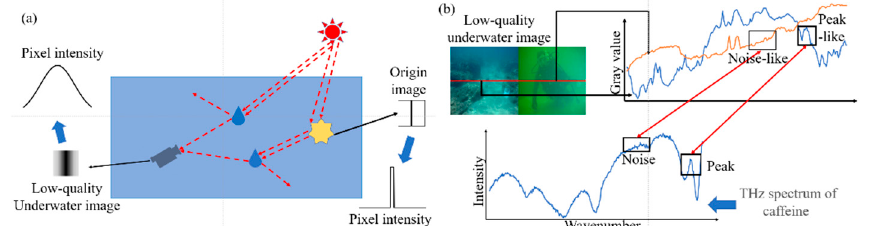
Figure 2. ( a ) The principle of underwater imaging. ( b ) Comparison of THz spectrum with the row pixel intensity of underwater images.